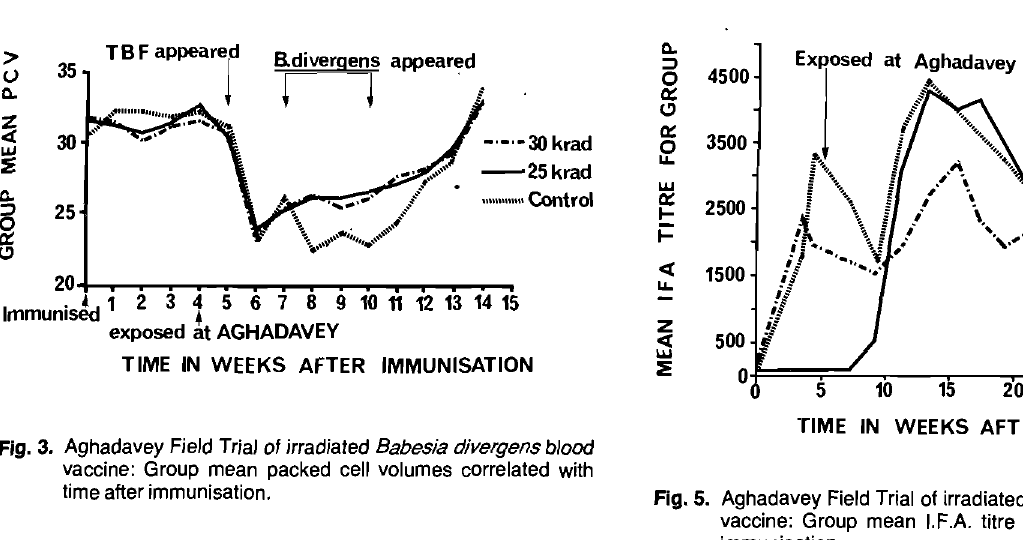
Fig. 5. Aghadavey Field Trial of irradiated Babesia div.erg~ns blood vaccine: Group mean LFA titre correlated with time after immunisation.